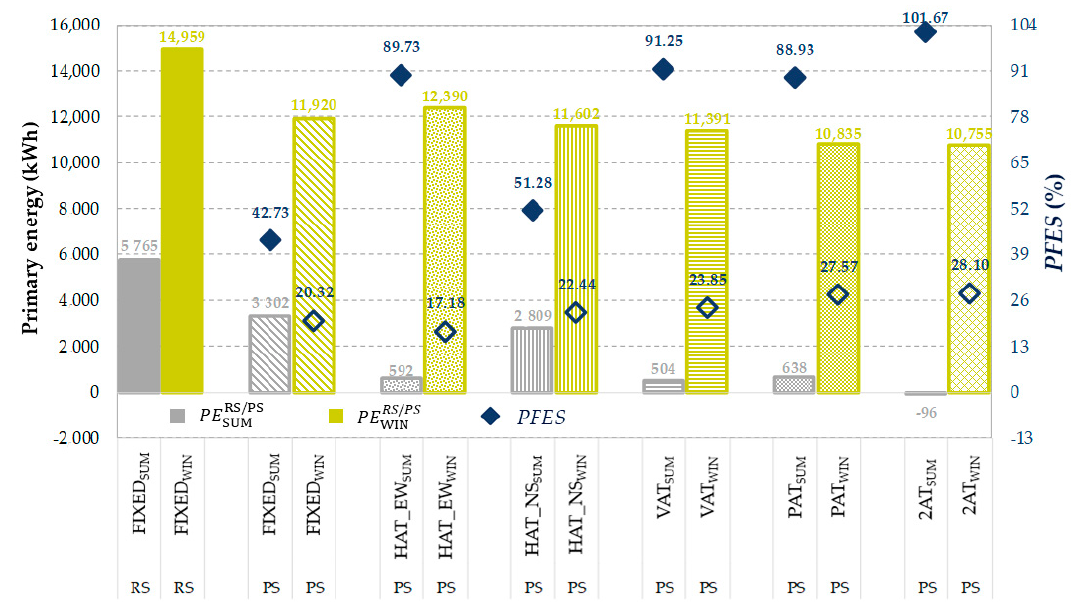
Figure 7. Primary energy demand of RS and PS, PFES index in Scenario_MV.